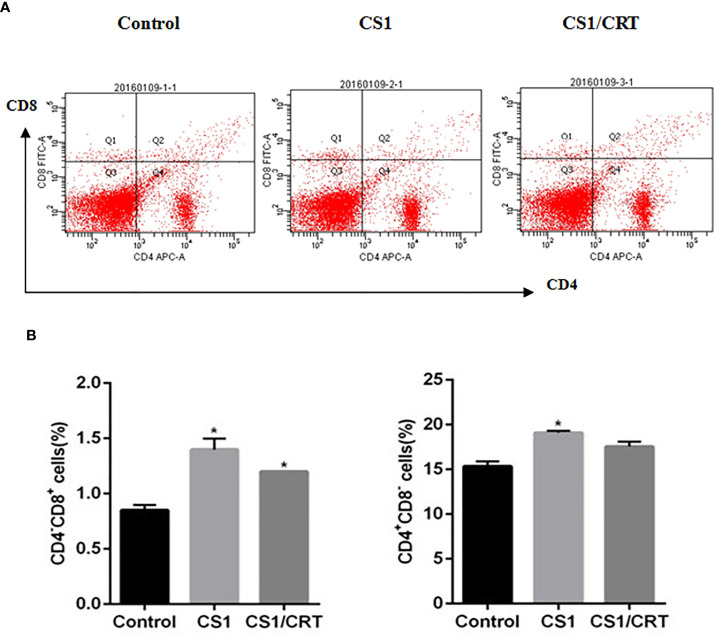
Analysis of T lymphocyte subsets from vaccinated mouse spleens. (A) FACS analysis was used to measure the percentage of CD4+ and CD8+ T cells. (B) The data are expressed as the mean ± SEM; *P < 0.05, compared with the control group.